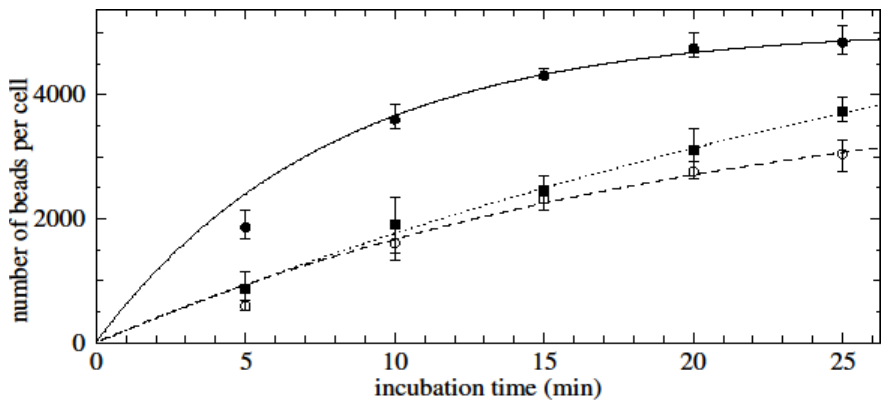
Figure 5. Time-dependent binding of anti-CD14 conjugated magnetic nanobeads to untouched CD14-positive cells. Solid line: 32 µg beads/100 µL, R 2 = 0.98; dashed line and circles, dotted line and square dots: 16 µg beads/100 µL, R 2 = 0.98 and 0.99. Concentration of target cells: 1 × 10 6 /100 µL. The experiments are from samples from three different blood